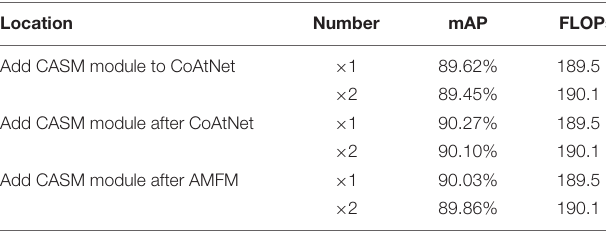
TABLE 10 | Experimental results of adding an attention mechanism to different positions and